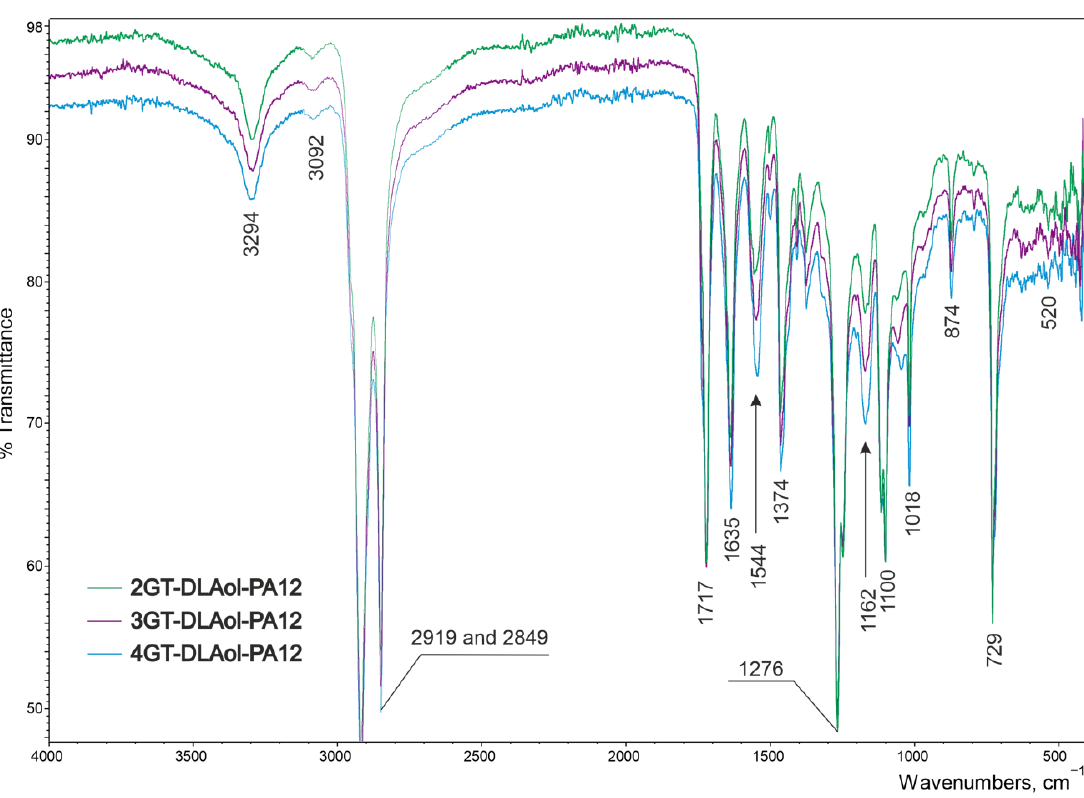
Figure 3. FT-IR spectra of terpolymer xGT-DLAol-PA12 where x = 2, 3 and 4.